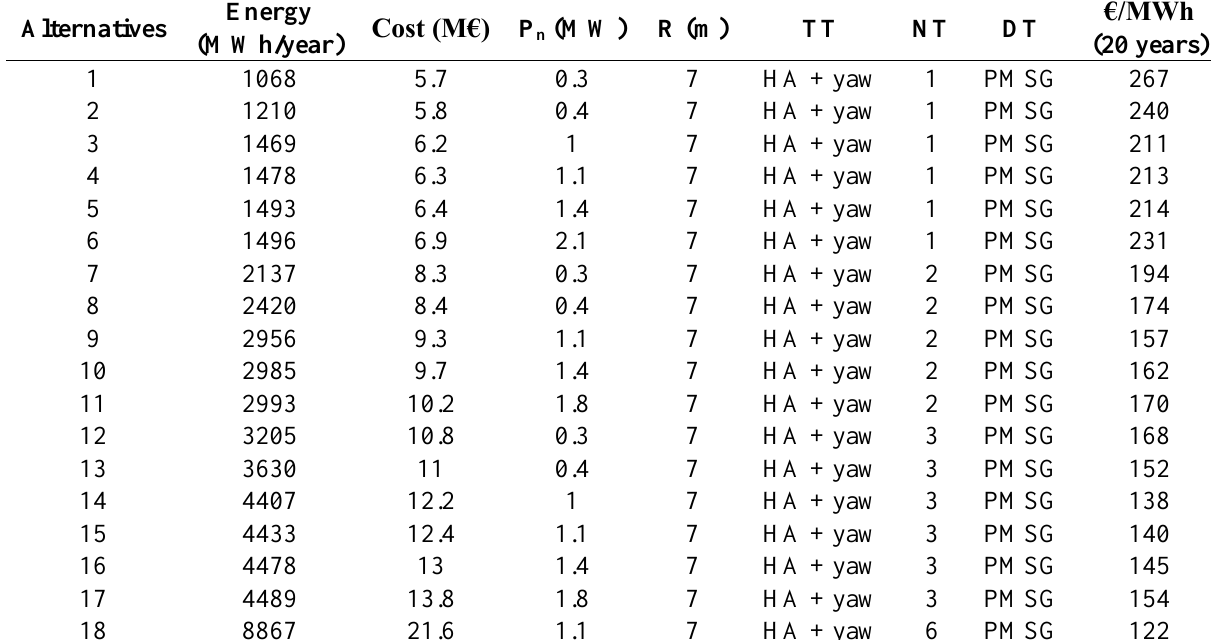
Table 2. Results of the genetic algorithm optimization. PMSG, permanent magnet synchronous generator; TT, turbine type; NT, number of turbines; DT, direct-drive turbine.